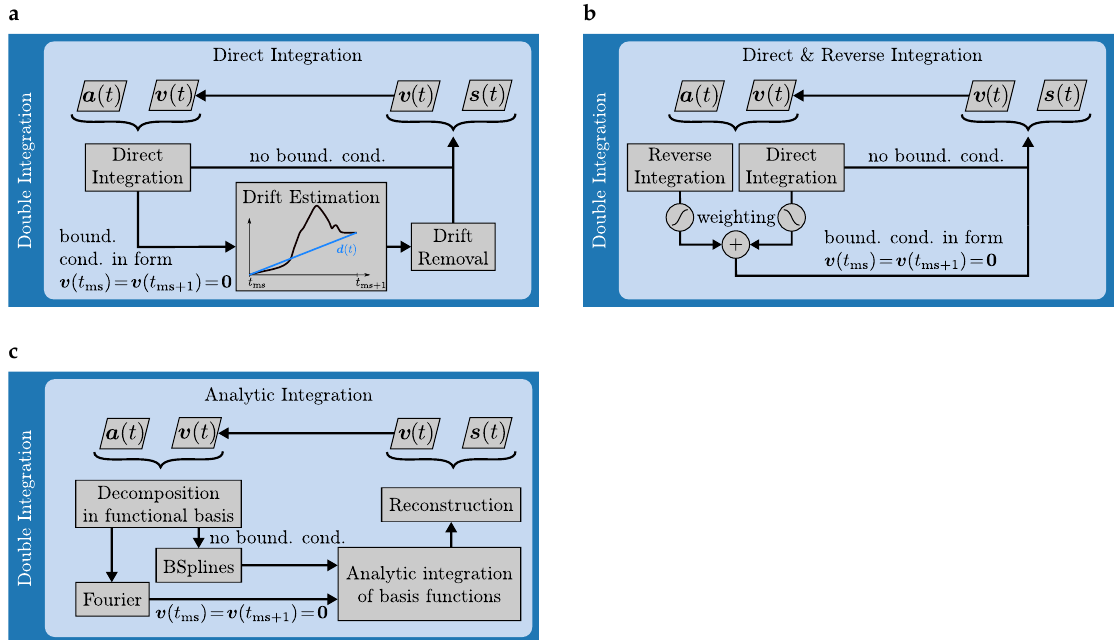
Figure 3. ( a – c ) Block diagrams for the double integration methods implemented in the context of this